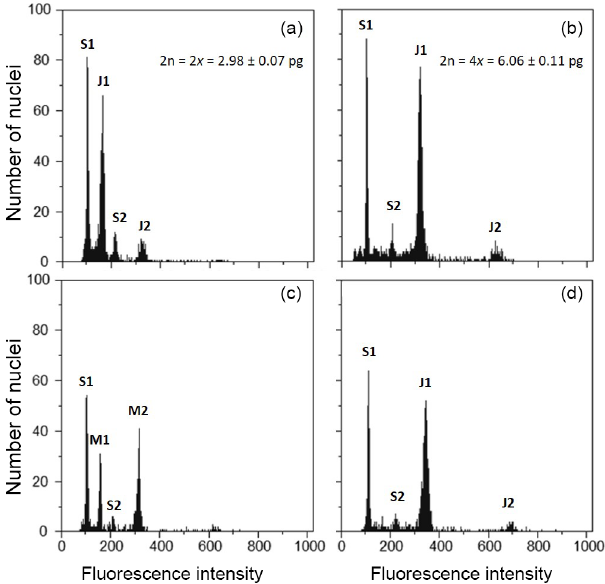
Figure 1. Flow cytometric histograms of J. maritima genome size analyses. Histograms of relative propidium iodide fluores- cence intensity of nuclei obtained from fresh leaves of S. lycoper- sicum “Stupické” (as reference standard, 2C = 1.96pg) and J. mar- itima : (a) natural diploid J. maritima ; (b) natural tetraploid J. mar- itima ; (c) diploid-tetraploid mixoploid individual obtained after colchicine treatment; and (d) DNA tetraploid individual obtained after colchicine treatment. S1 and S2 correspond to G 1 and G 2 peaks of S. lycopersicum , respectively; J1 and J2 correspond to peak G 1 and G 2 of J. maritima , respectively; M1 and M2 correspond to nuclei with 2C and 4C genome size values, respectively. Mean genome size values ( ± SD) of natural diploid and tetraploid popu- lations of J. maritima are provided in the respective